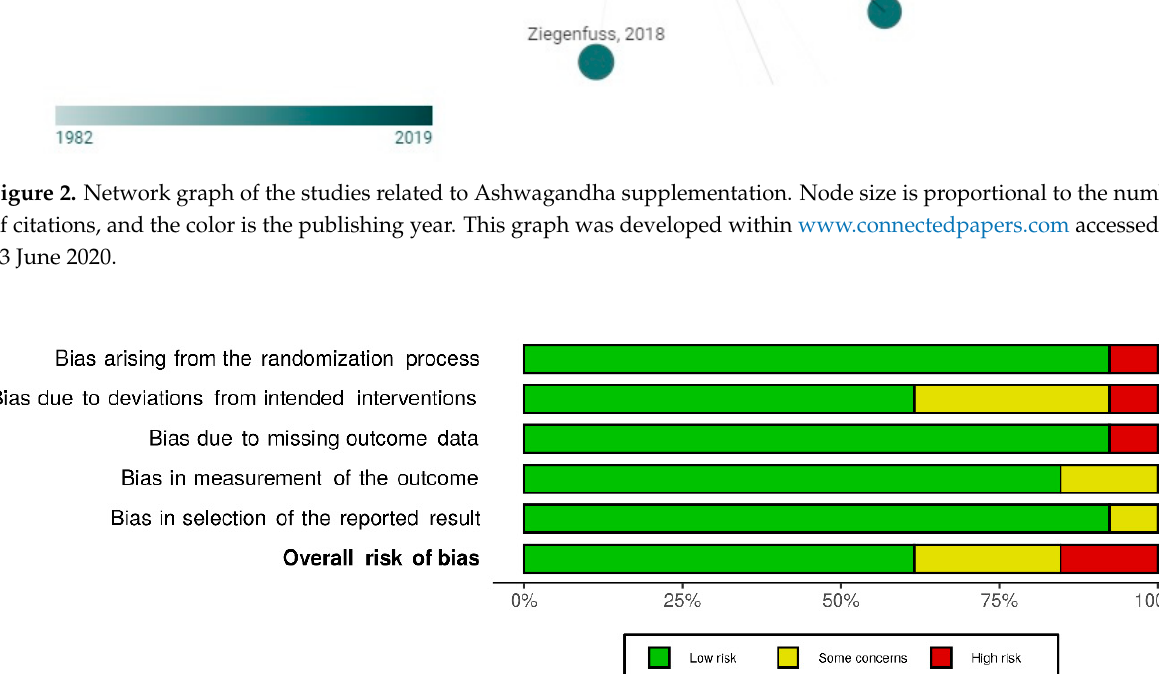
Figure 3. Risk of bias summary for included studies. Weighted bar-chart of the distribution of risk-of-bias judgments. These graphics were obtained using the robvis package within the R statistical computing environment.